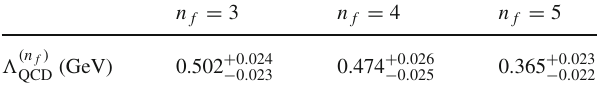
( n f ) (in unit: GeV) for the QCD